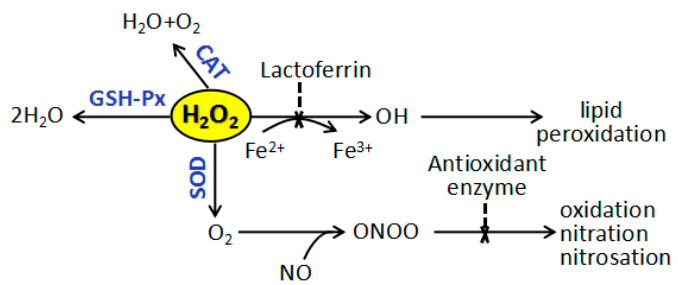
Figure 8. Antioxidant system of living organism.